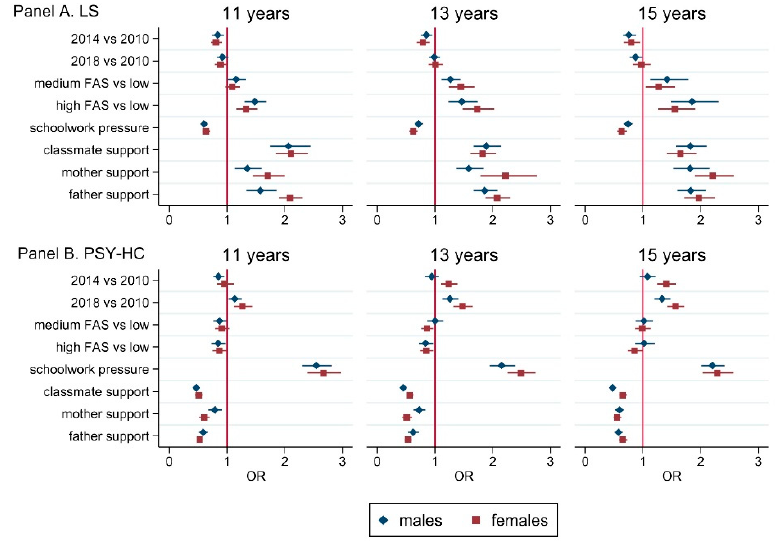
Figure 3. Multivariable regression analysis (OR (95%CI)) performed on LS ( Panel A ) and PSY ‐ HC ( Panel B ), stratified by gender and age groups. Abbreviations. LS: life satisfaction ≥ 9; PSY-HC: ≥ 2 psychological health complaints more than once a week. Adjustment variables: survey year, family